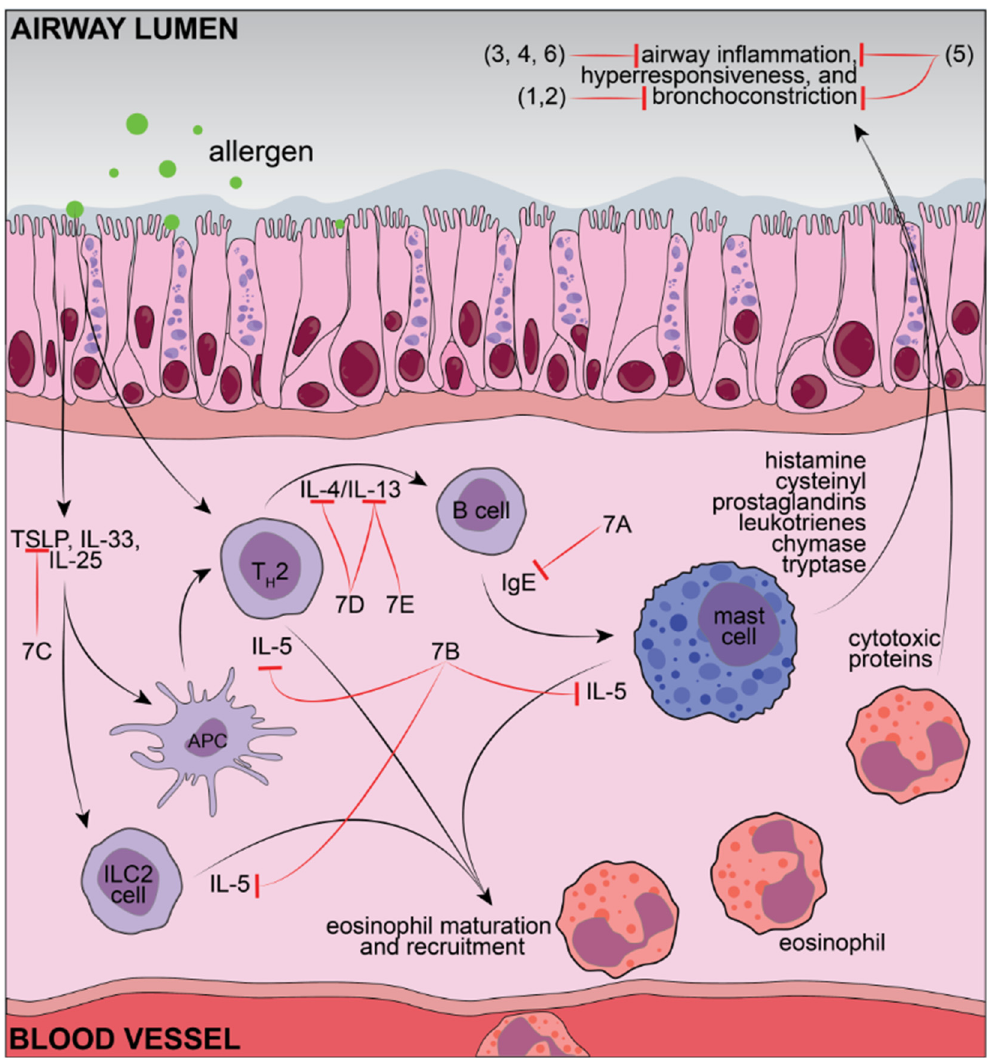
Figure 2. Th2 inflammation in response to allergens in asthma and targets of drugs currently used in the treatment of allergic asthma for humans: (1) Short-acting bronchodilators ( β 2-agonists; albuterol, pirbuterol, and levalbuterol) and antimuscarinics (ipratropium bromide) inhibit bronchoconstriction; (2) Long-acting bronchodilators ( β 2-agonists; salmeterol, formoterol, vilanterol, and isoproterenol) and muscarinic antagonists (tiotropium bromide) inhibit bronchoconstriction; (3) Inhaled corticosteroids (fluticasone propionate, budesonide, mometasone, beclomethasone, and ciclesonide) inhibit inflammatory response; (4) Leukotriene modifiers (zafirlukast, montelukast, and zileuton) inhibit hyperresponsiveness and inflammatory response; (5) Theophylline inhibits bronchoconstriction and inflammatory response; (6) Systemic corticosteroids (prednisone and methylprednisolone) inhibit inflammatory response; (7) Monoclonal antibodies (7A) omalizumab (anti-IgE), (7B) mepolizumab, reslizumab, and benralizumab (anti-IL-5), (7C) tezepelumab (anti-TSLP), (7D) dupilumab (anti -IL-4/IL-13), and (7E) lebrikizumab (anti-IL-13; not approved for asthma so far) inhibit specific signaling pathways related to Th2 inflammatory response. Figure was designed in Adobe Illustrator 2023 (Adobe©, San Jose, CA, USA).